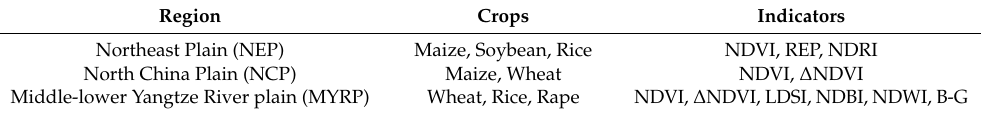
Table 2. Di ff erent indicators used for crop classification in the di ff erent study regions. Region